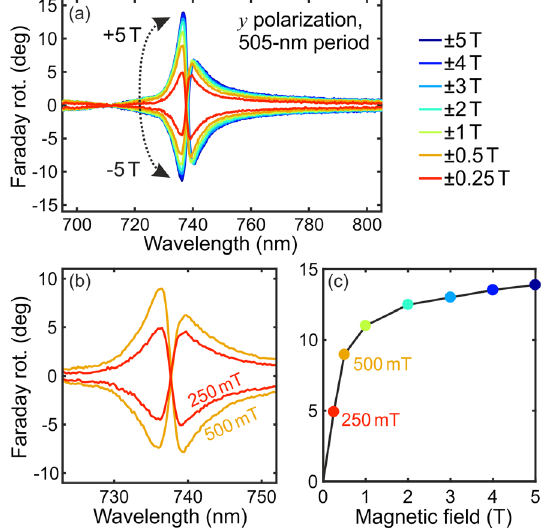
FIG. 5. (a) Measurement of the magnetic field dependence of the polarization rotation for a period of 505 nm. (b) Closer view on the rotation spectra for weak magnetic fields. Already for 250 mT the Faraday rotation reaches values of over 4°.